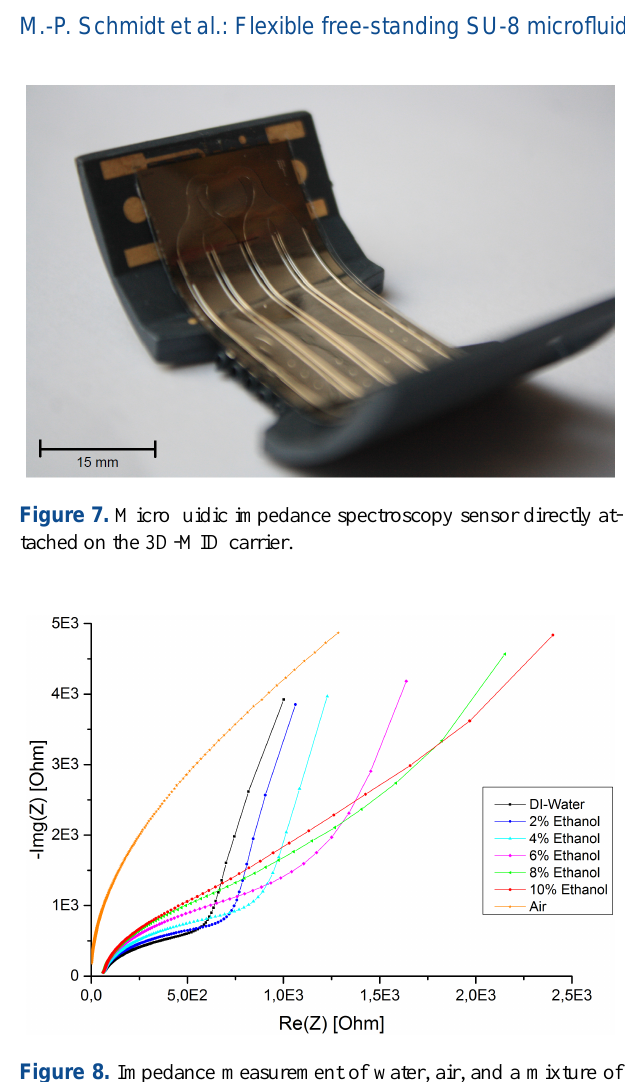
Figure 8. Impedance measurement of water, air, and a mixture of water and ethanol in a Cole–Cole plot for the frequency range of 10kHz–10MHz.